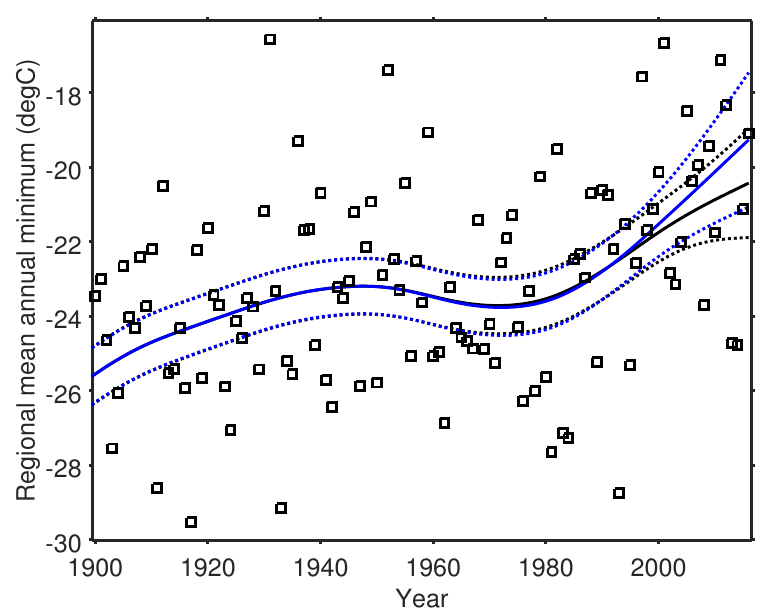
Figure 8. Mean annual minimum temperature averaged across stations in Eastern North America (squares), and smoothed trends with 95% confidence intervals using data only up to 2011 (blue line) or all data up to 2016 (black